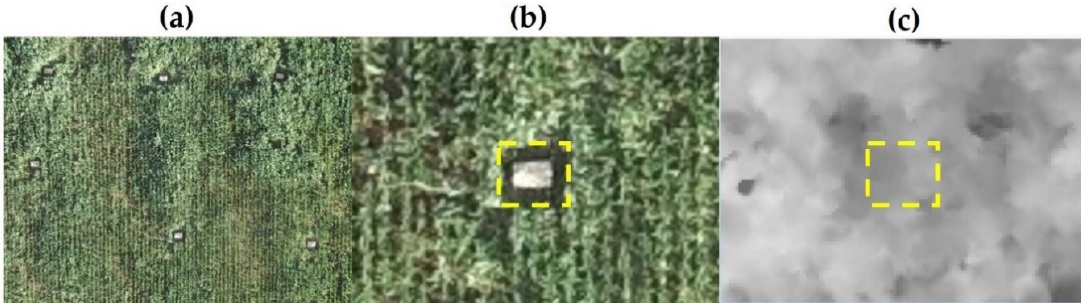
Figure 1. Procedure to extract plot-wise variables from UAV-based dataset. ( a ) Orthomosaic built from images collected after sampling procedure; ( b ) Mask created for the sampled area; ( c ) Extraction of CSM data using generated masks.